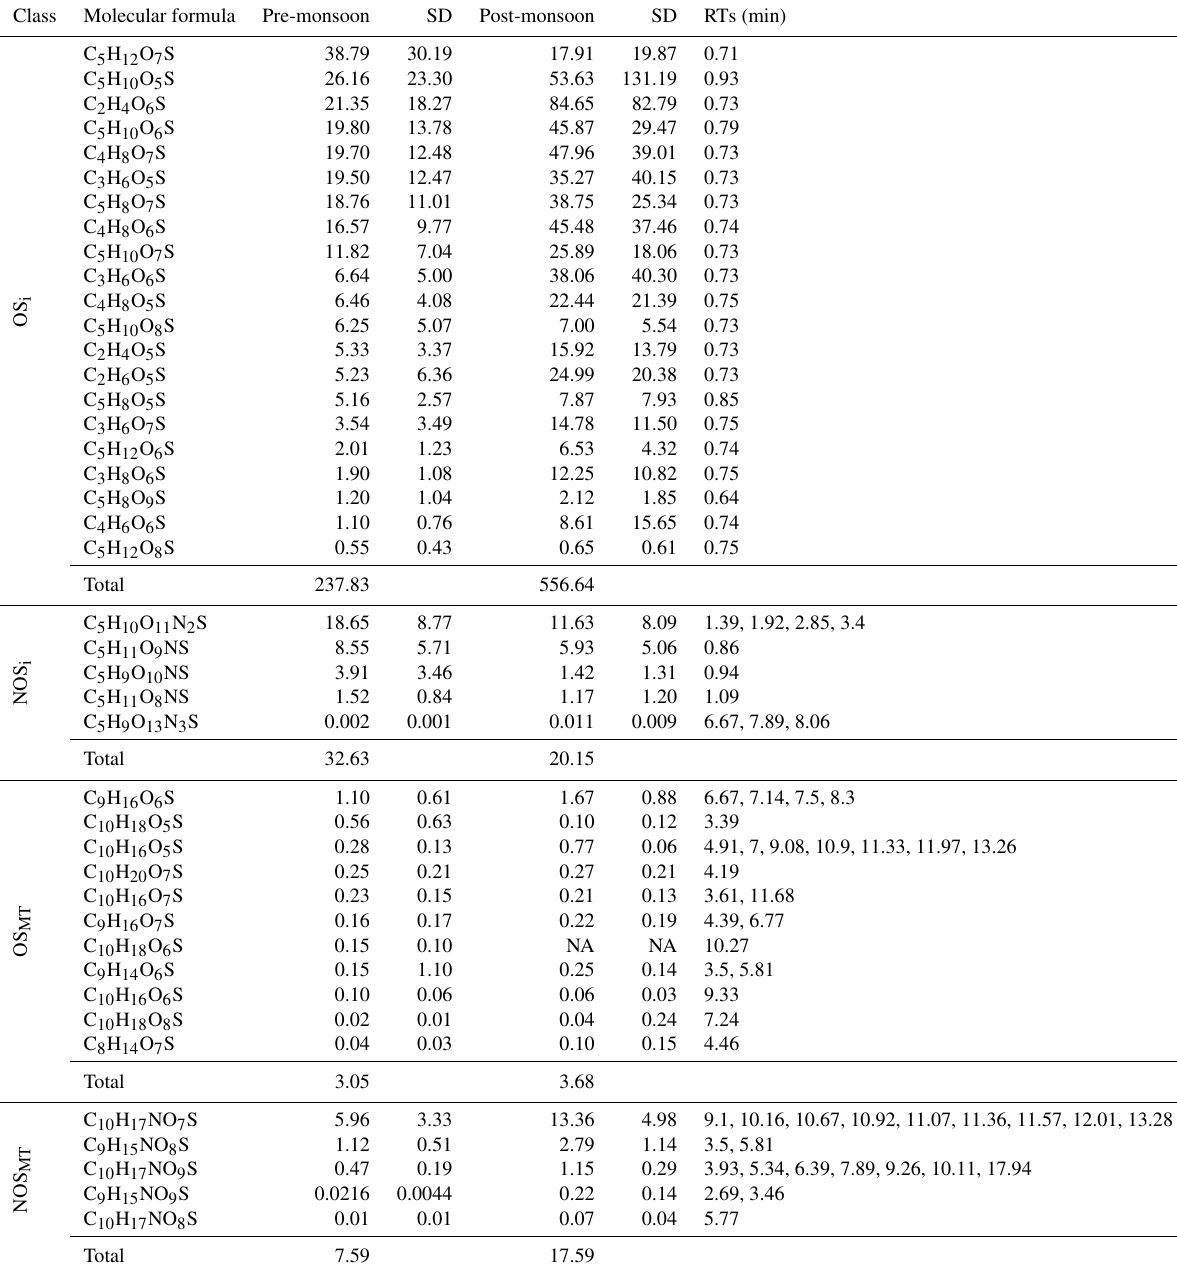
Table 1. Molecular formulae, retention times (RTs), and time-weighted means (ngm − 3 ) of organosulfate (OS) and nitrooxy organosulfate (NOS) species from isoprene (i) and monoterpenes (MTs) observed across pre- and post-monsoon campaigns in Delhi.